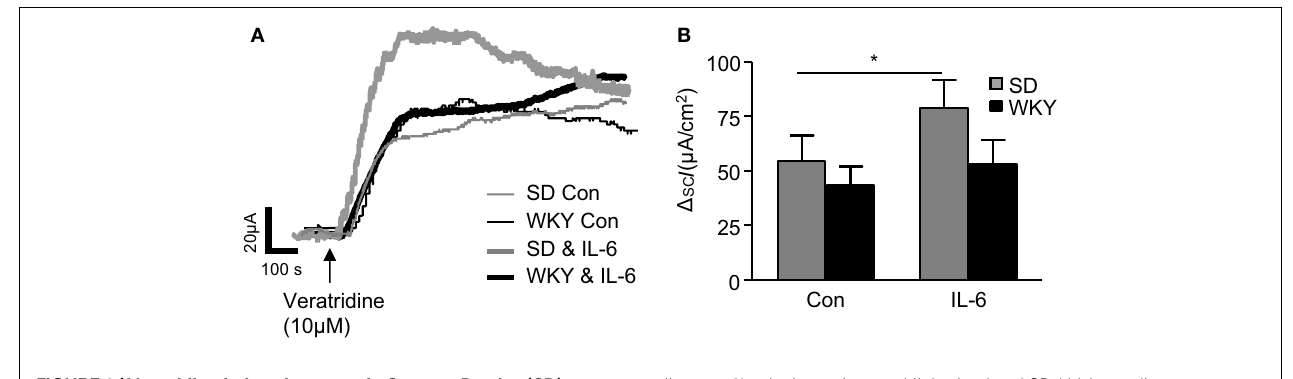
FIGURE 2 |Veratridine-induced currents in Sprague Dawley (SD) andWistar Kyoto (WKY) colons. (A) Representative traces illustrate the secretory current ( I SC ) induced by exposure to veratridine (10 µ M) in non-stimulated (con) SD (thin gray line, n = 7) andWKY (thin black